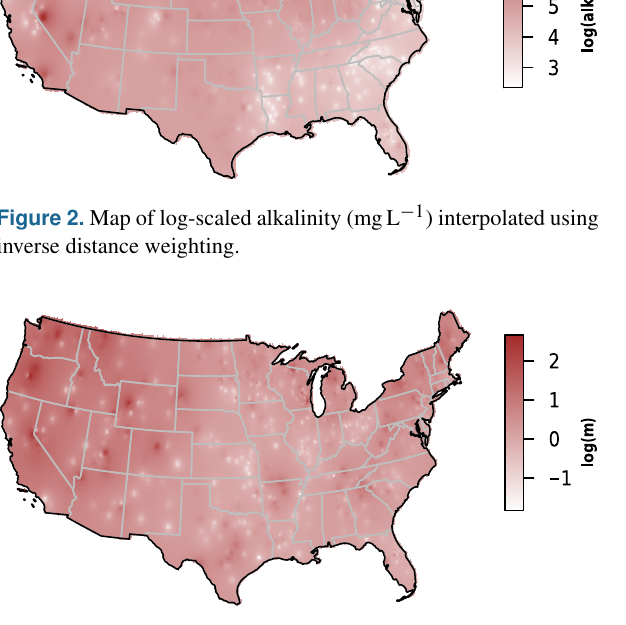
Figure 3. Map of Secchi depth (m) interpolated using inverse dis- tance